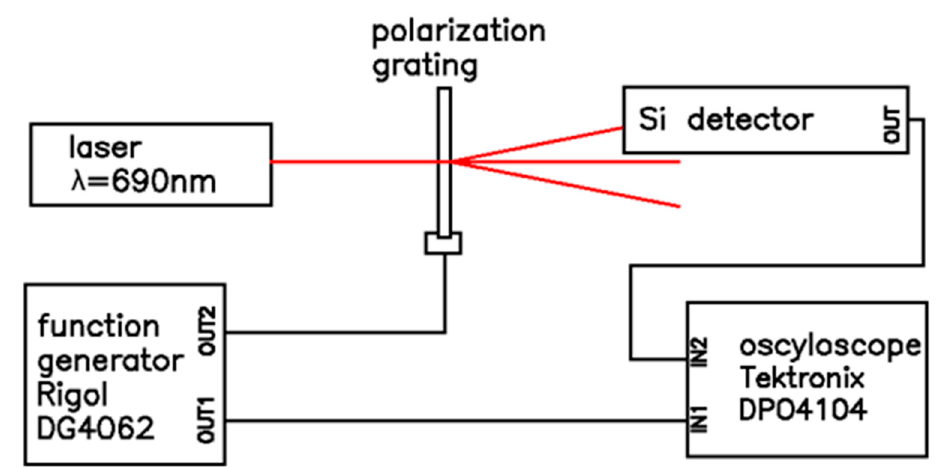
Figure 1. Experimental set-up for measurements of switching times of the prepared liquid crystal (LC) gratings.